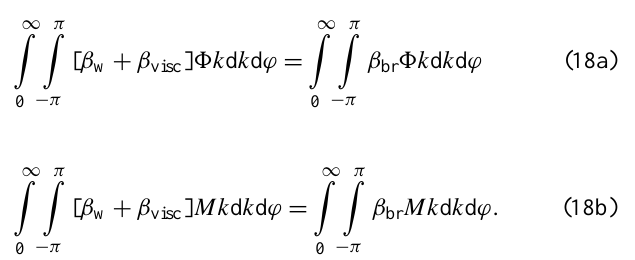
Figure 1. Curvature spectrum B(k, ϕ )=k 4 F(k, ϕ ) in the high wavenumber range (k ≥ 25k p ) as given by Elfouhaily et al.’s (1997) model (solid lines) and by Kudryavtsev et al.’s (2003) model (dashed lines), plotted for a 10m/s wind speed. For each model spectrum, the thick line stands for the spectrum along the wind direction ( ϕ =0), while the thin line stands for the spectrum in the crosswind direction ( ϕ = π /2).